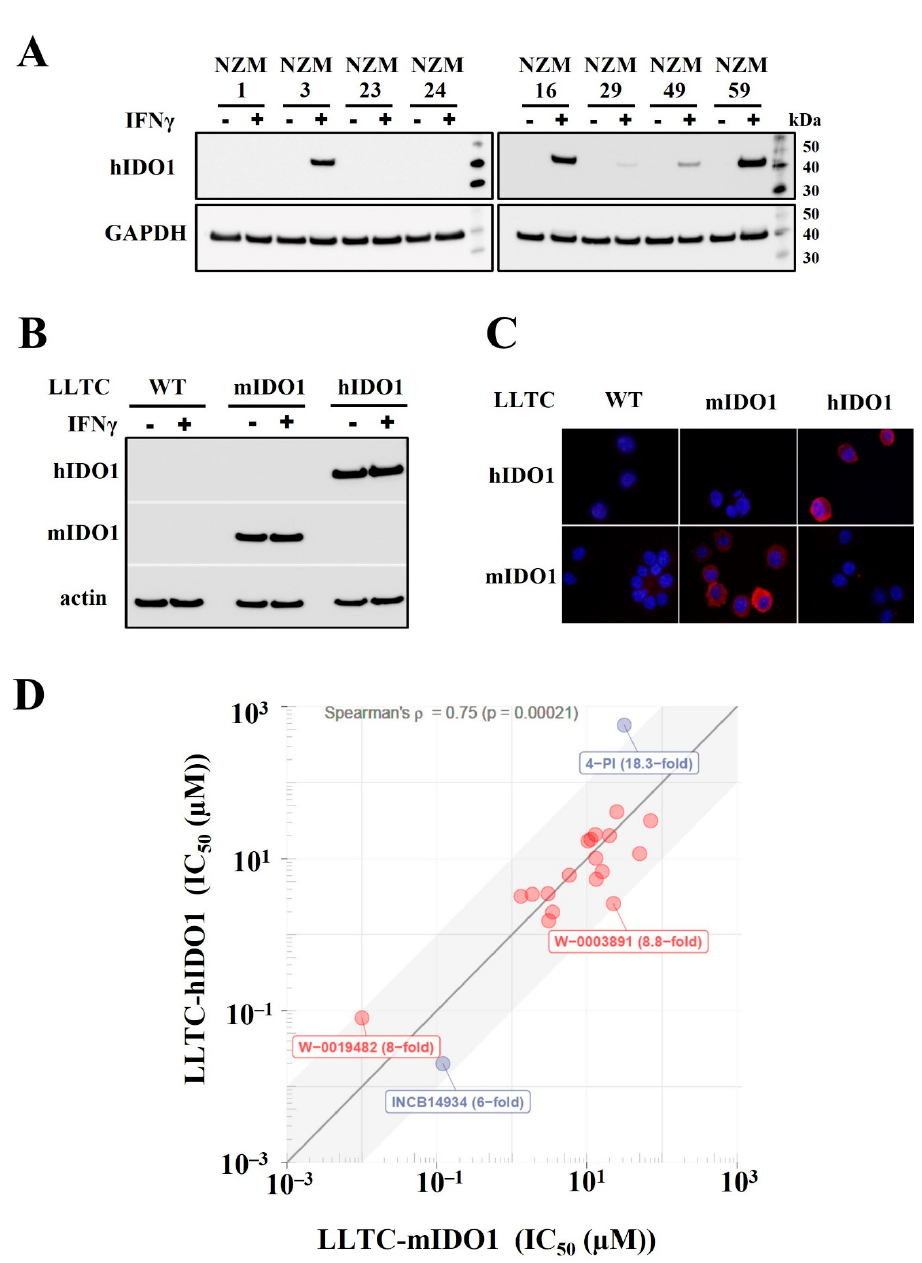
Figure 1. ( A ) Expression of human IDO1 in NZM lines without and after incubation with hIFN γ . ( B ). Expression of murine or human IDO1 in LLTC − WT, LLTC-mIDO1 and LLTC-hIDO1 lines without or after 72 h incubation with mIFN γ . ( C ) LLTC-WT, LLTC-mIDO1 and LLTC-hIDO1 cells immunostained with anti-human IDO1 or anti-mouse IDO1antibodies. ( D ) IC 50 values measured in cell-based assays against LLTC-hIDO1 plotted against IC 50 values measured against LLTC-mIDO1 for WEHI compounds (red); reference controls INCB14943 and 4-PI (blue). Spearman’s ρ and the p -value in brackets denote Spearman’s rank correlation coefficient and the probability value of that correlation,